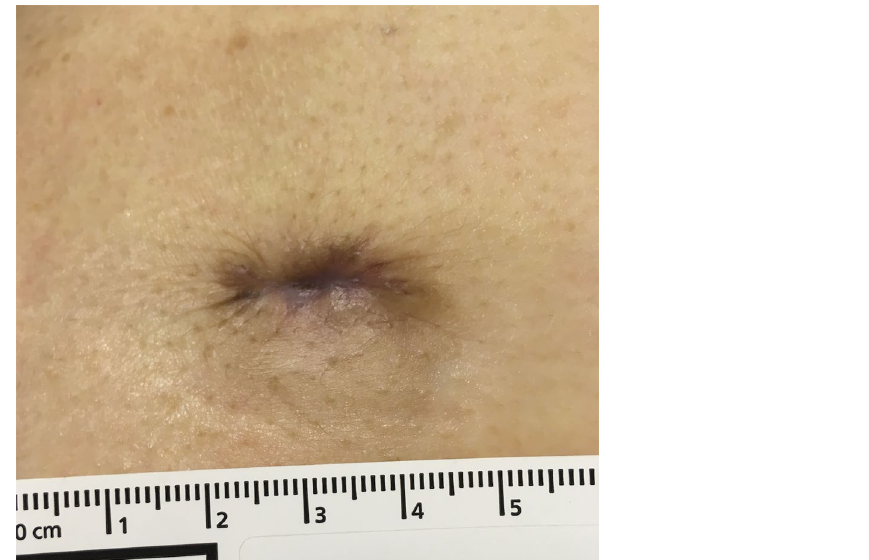
Figure 3. The epithelialisation was